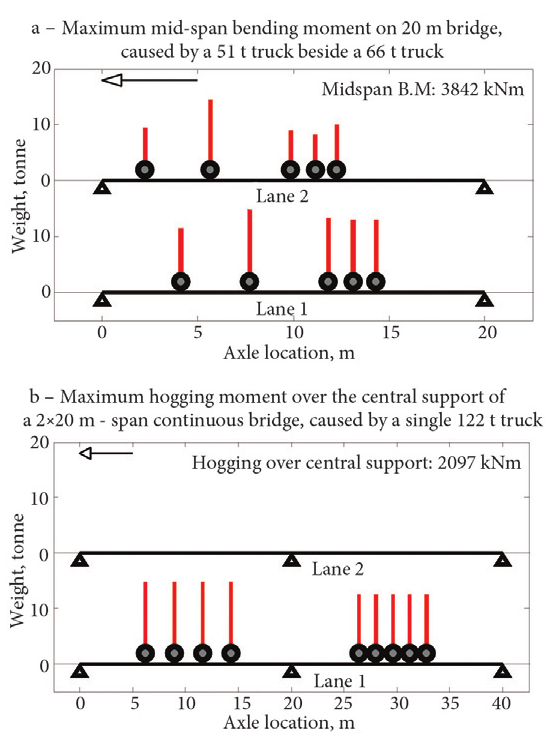
Fig. 3. Examples of the events causing maximum load effects for the 10 years of microsimulation